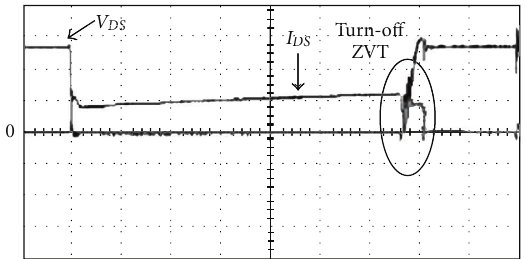
Figure 16: ( V DS 1 : 50V/div, I DS 1 : 5 A/div, time: 1 μ s/div). Measured voltage and current waveforms of switch in the interleaved boost converter with two sets of turn-o ff snubbers.